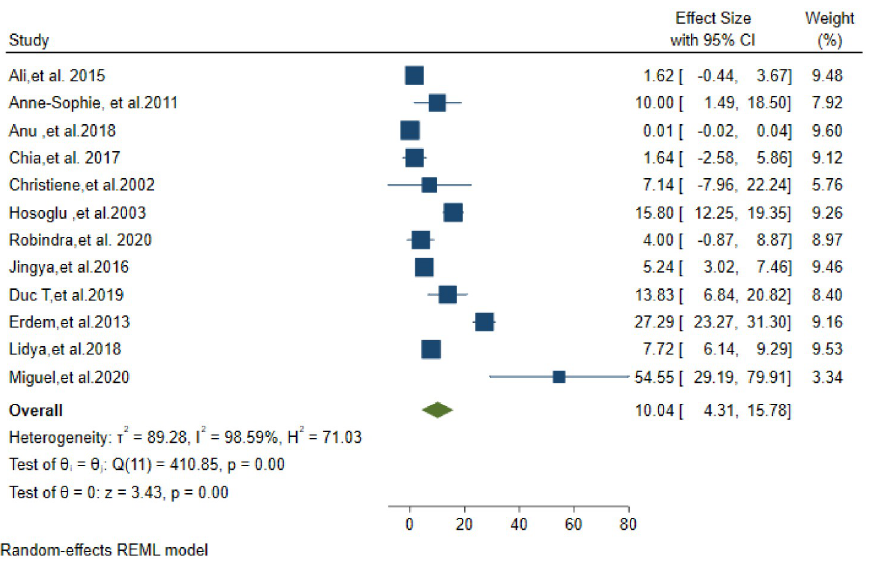
Fig 3. ZN AFB microscopy positivity of CSF in TBM suspected patients.